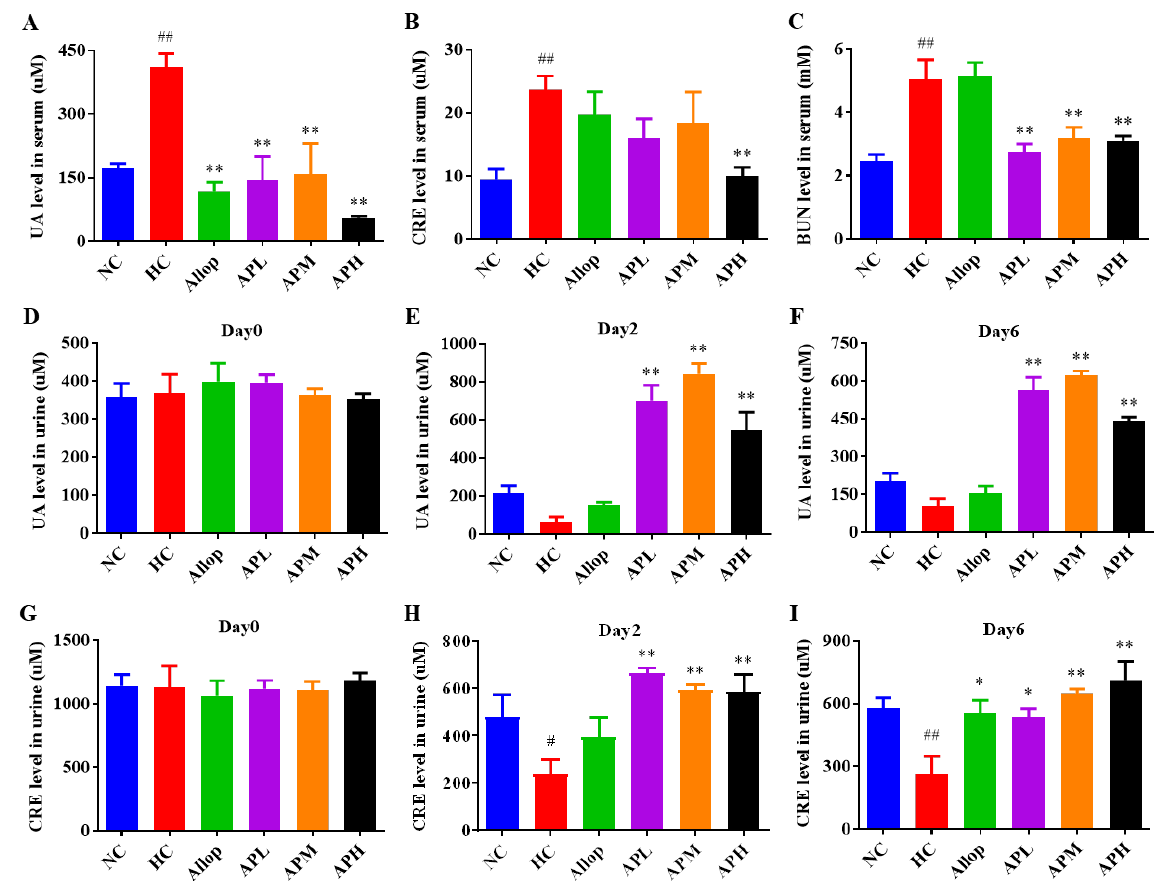
Figure 1. Apigenin reduces serum levels of UA, CRE, and BUN, and increases urine levels of UA and CRE in HUA mice. Serum levels of UA ( A ; µ M, n = 10), CRE ( B ; µ M, n = 10), and BUN ( C ; mM, n = 10). Urine levels of UA on days 0, 2, and 6 ( D – F ; µ M, n = 10, 6 and 10). Urine levels of CRE on days 0, 2, and 6 ( G – I ; µ M, n = 10, 10 and 7). Allop denotes allopurinol-treated group, APL denotes low dose of apigenin-treated group, APM denotes medium dose of apigenin-treated group, APH denotes high dose of apigenin-treated group. ## p < 0.01, # p < 0.05 vs. the NC group. ** p < 0.01, * p < 0.05 vs. the HC group.